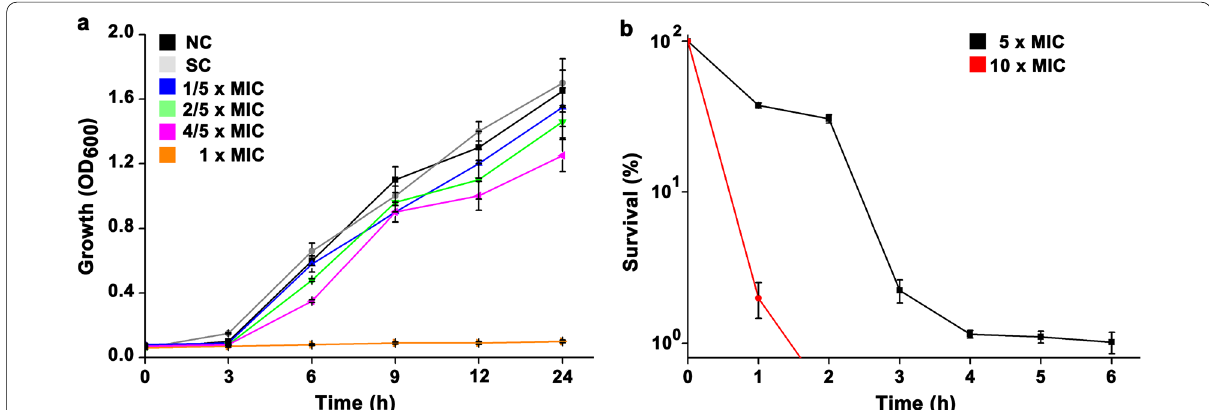
Fig. 1 The inhibitory effect of TFs on the growth of S. mutans UA159. a The growth curves of S. mutans UA159 in medium containing TFs with concentrations below the MIC. b the killing curves of S. mutans UA159 upon TFs treatment with concentrations higher than the MIC. All experiments were conducted with three biological replicates, and error bars represent standard deviations. NC and SC indicate negative control and solvent control,